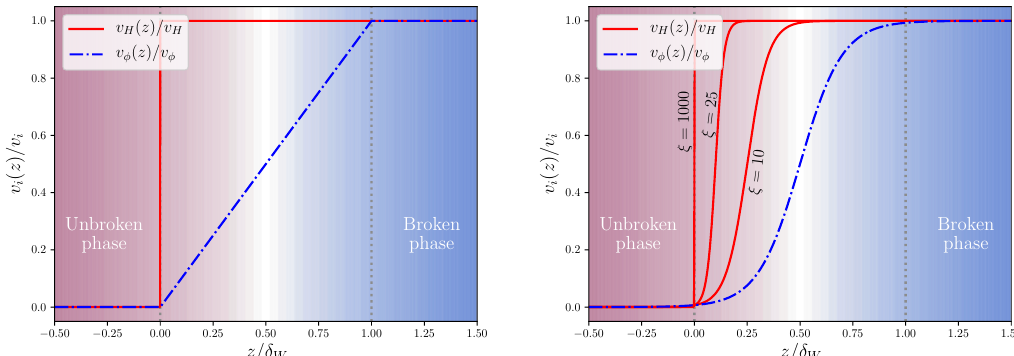
Figure 3 . Pro(cid:12)le for the vev of the scalars in the bubble wall. The left panel shows the FLOR pro(cid:12)le from eq. (3.12) while the right panel corresponds to the second set of pro(cid:12)les from eq. (3.13) with smooth and continuous functions for di(cid:11)erent values of (cid:24)